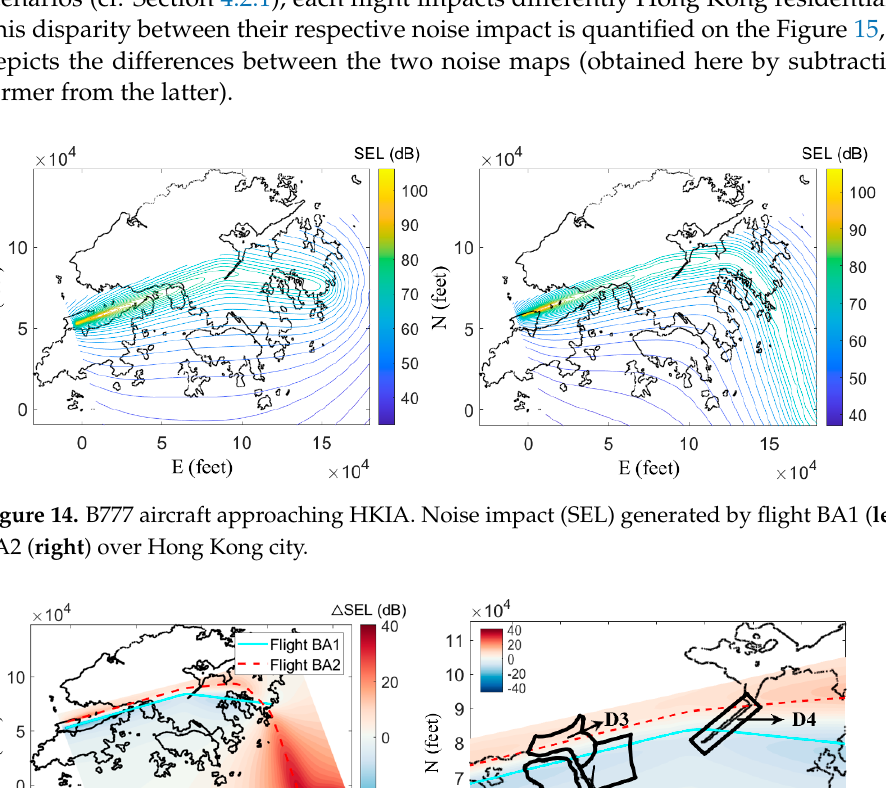
Figure 15. Difference in the noise impact ( ∆ SEL) by flights BA1 and BA2 (as obtained by subtracting the former from the latter), with a closer view provided on right side.